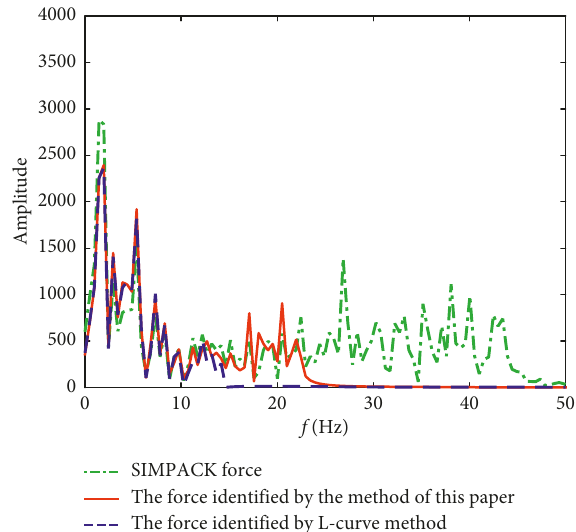
Figure 27: Amplitude-frequency curve of the two methods for F identification when the noise level is 10%. 2